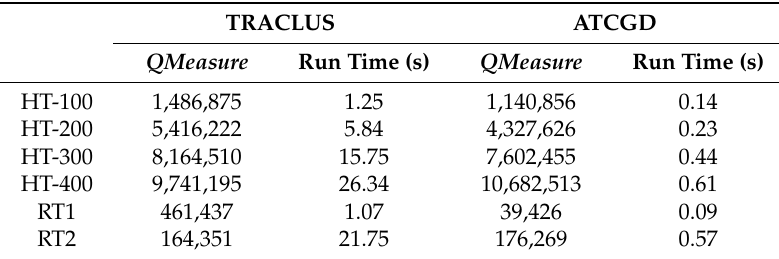
Table 1. Comparison of clustering quality between ATCGD and